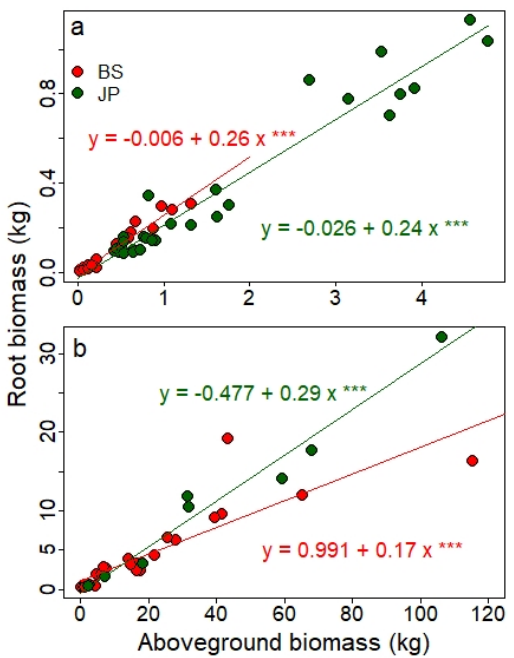
Figure 6. Relationships between shoot mass and root mass of black spruce (red circles) and jack pine (green circles) for ( a ) planted and ( b ) natural trees. *** indicates p < 0.001. Table 7. The root:shoot ratio (RSr) of planted ( n = 28 for BS and JP) and natural ( n = 24 for BS and 8 for JP) trees and their minimum and maximum values. Results presented as mean ± SE. Planted Trees Natural